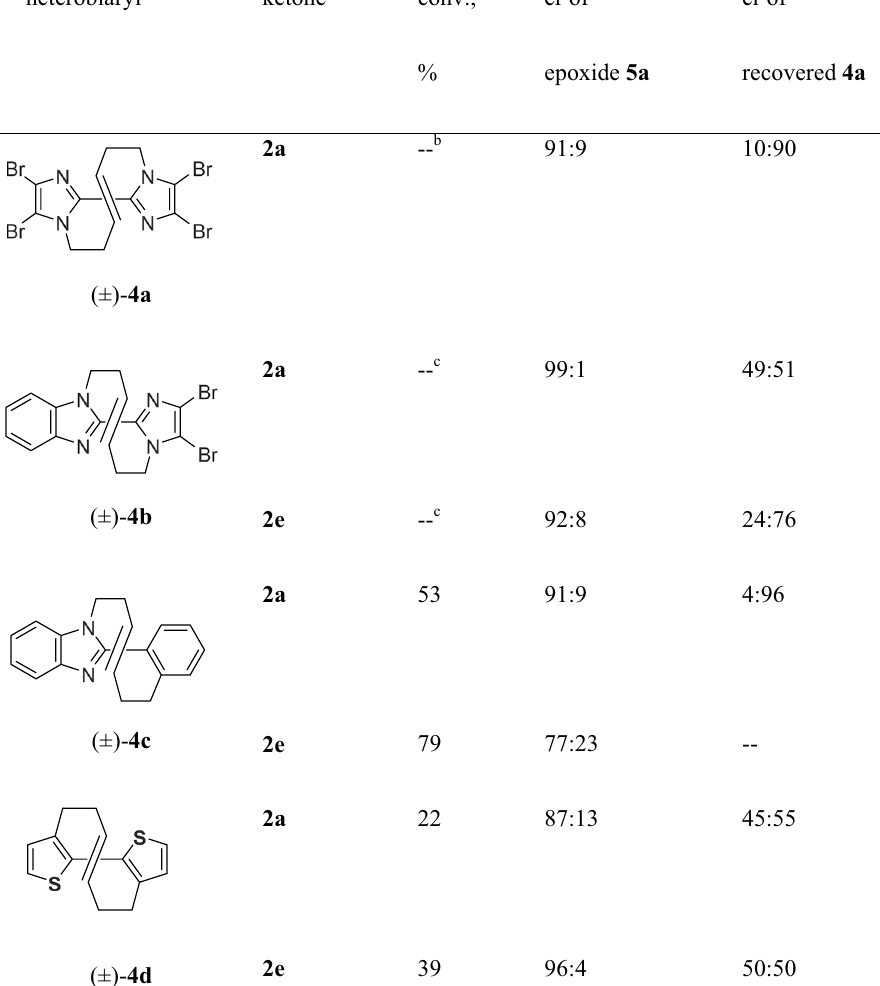
Figure 6. Table of the results on kinetic resolution of vine-shaped bithiophene 4 with chiral ketone 2a and 2e a . a The reaction was carried out 0.6 eq of chiral ketone 2 , oxone ® (2.7 eq), n Bu 4 NHSO 4 (4.0 mol %), and K 2 CO 3 (11.6 eq) in CH 3 CN/aq. Na 2 (edta) (1.5:1 v/v) at 40 °C for 24 h. b The reaction proceeded to give epoxide 5a accompanied by inseparable and unidentified by-products. The ratio of 4a : 5a was 50:50 by HPLC analysis. c The ratio of 4b : 5b was 99:1 (with 2a ) and 62:38 (with 2e ), respectively, by HPLC